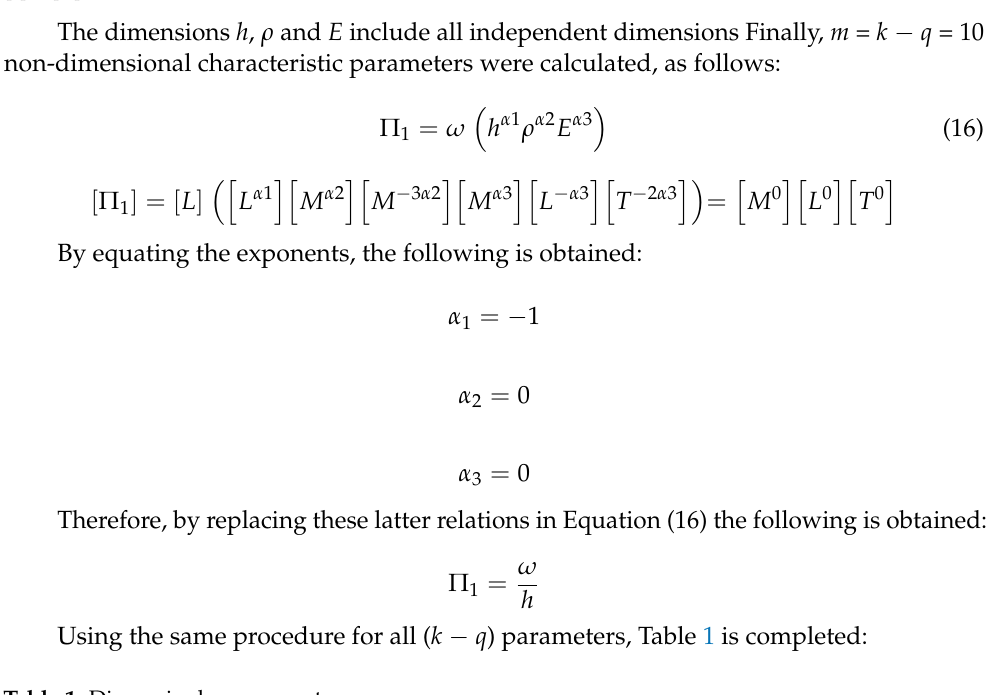
Table 1. Dimensionless